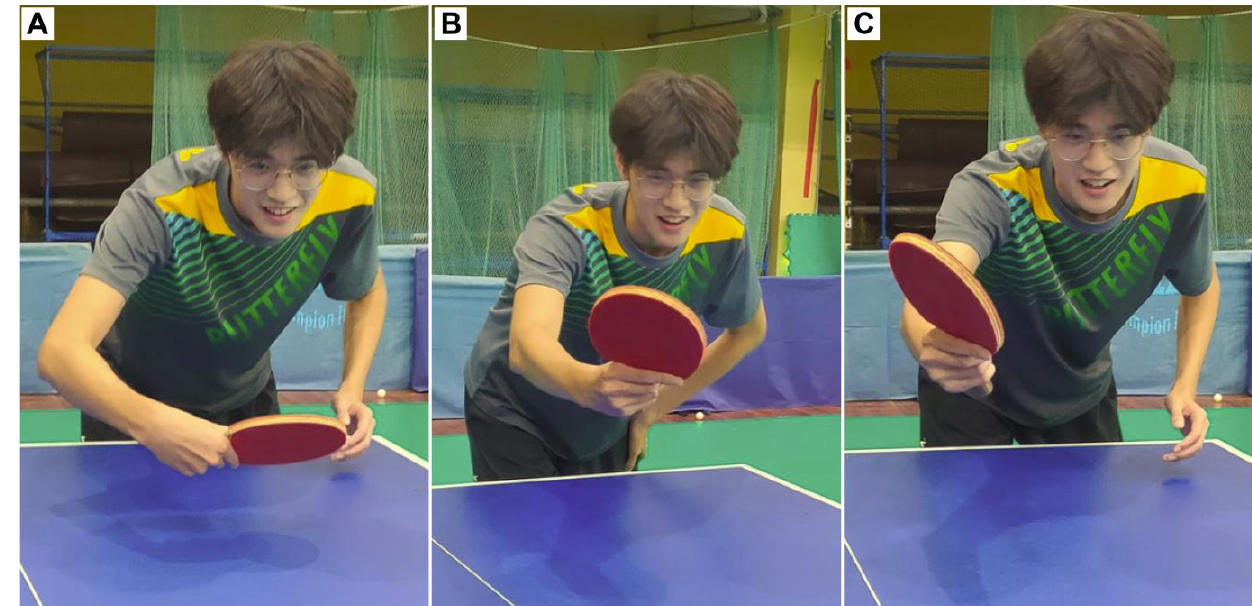
Figure 16. ( A ) Backhand flip action (start). ( B ) Backhand flip action. ( C ) Backhand flip action (end). The backhand flip action from the start to the end.